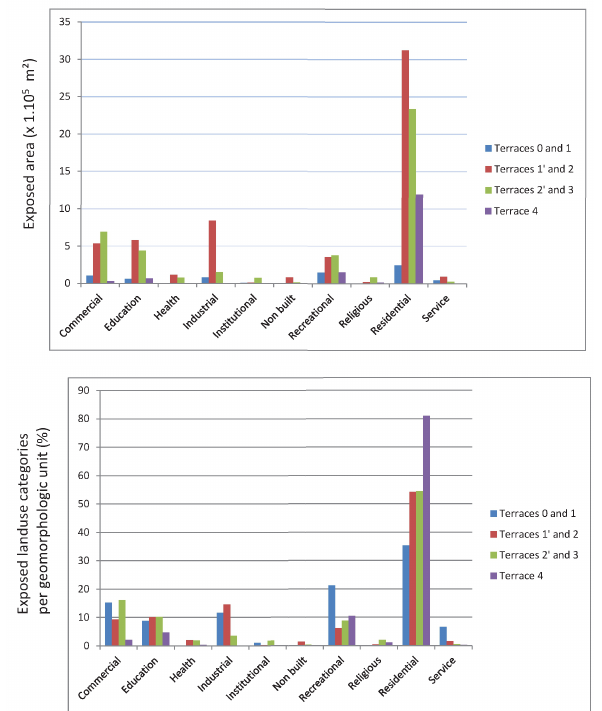
Fig. 7. Exposure of at-risk land-use types along the R´ıo Chili val- ley, according to the height of the terrace above the channel (after Vargas-Franco et al., 2010, modified). The delineation of terraces is based on the hazard-zone map shown in Fig. 6. The census of activ- ities is based on field surveys and aerial surveys using Google Earth Pro™.